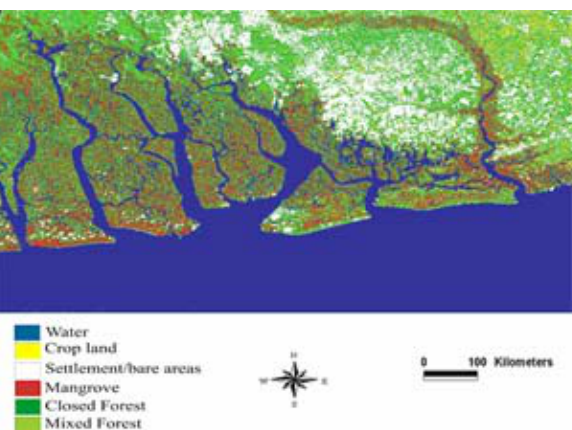
Figure 3: Classified image of Landsat TM, June 15, 2000